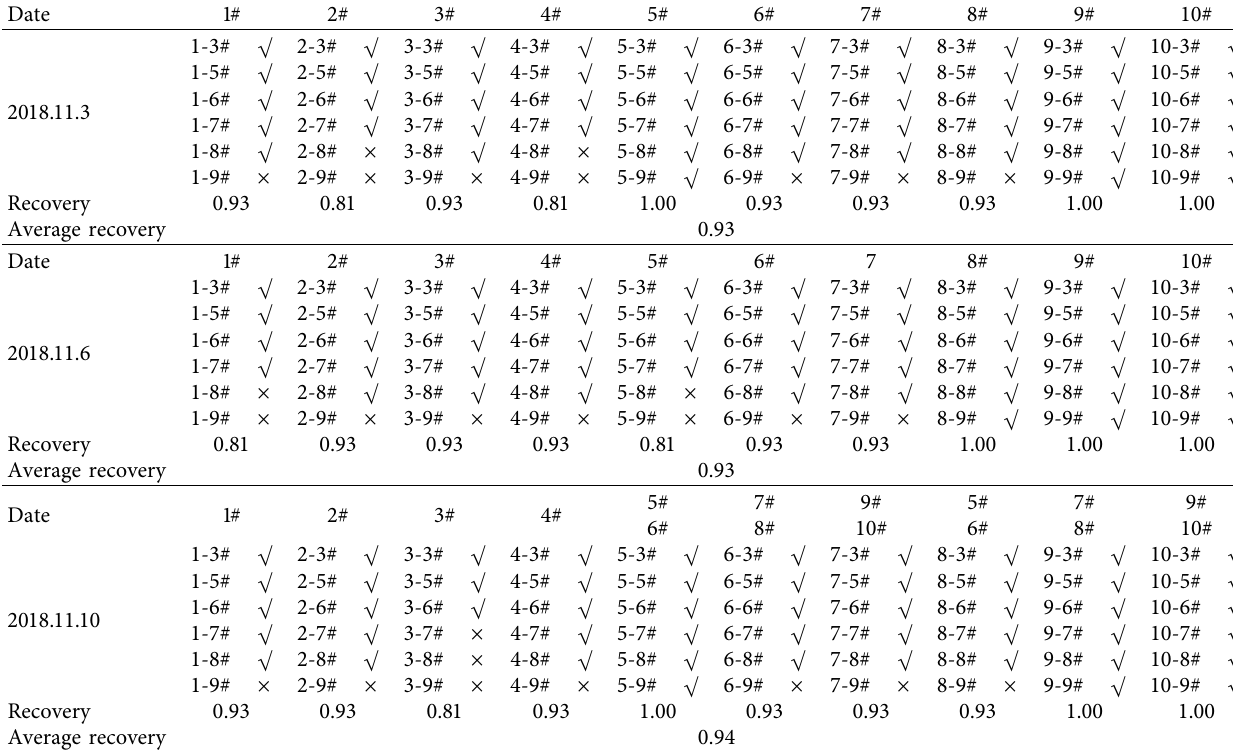
Table 4: Monitoring data of top coal recovery under the condition of one cutting and one caving with single-sequence coal caving (“ √ ” means the monitoring point has been recovered, “ × ” means the monitoring point has not been recovered).